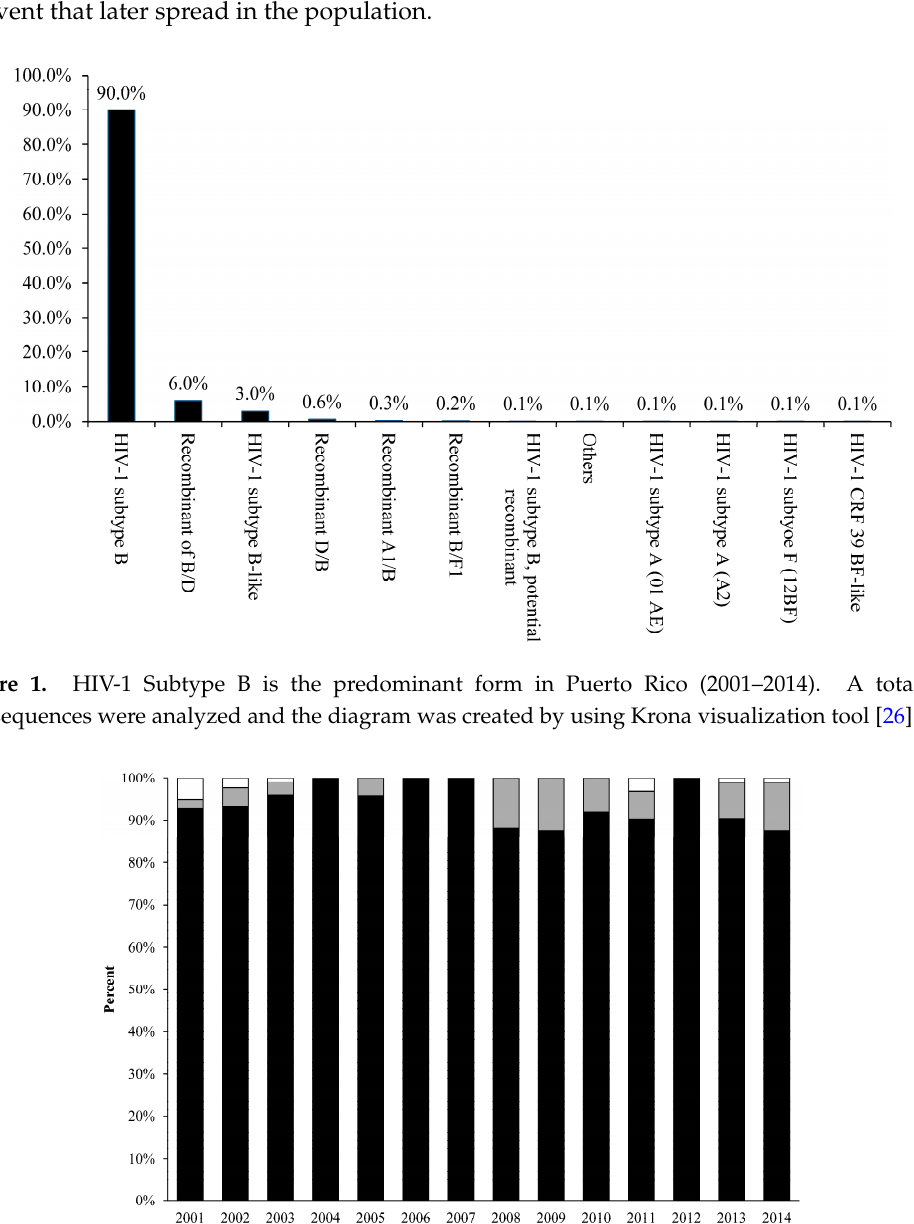
Figure 3. Bayesian skyline plots for the HIV-1 recombinant B/D in Puerto Rico (2011–2014). ( n = 40) The plots represent number of effective population size ( Y = log10) through time ( X = time). The line represents the median of number of lineages with upper and lower 95% highest posterior density interval (HPD) estimates. The mean mutation rate was estimated as 1.665 × 10 − 3 nucleotide substitutions per site per year. A constant rate of evolution is observed in the last decade.